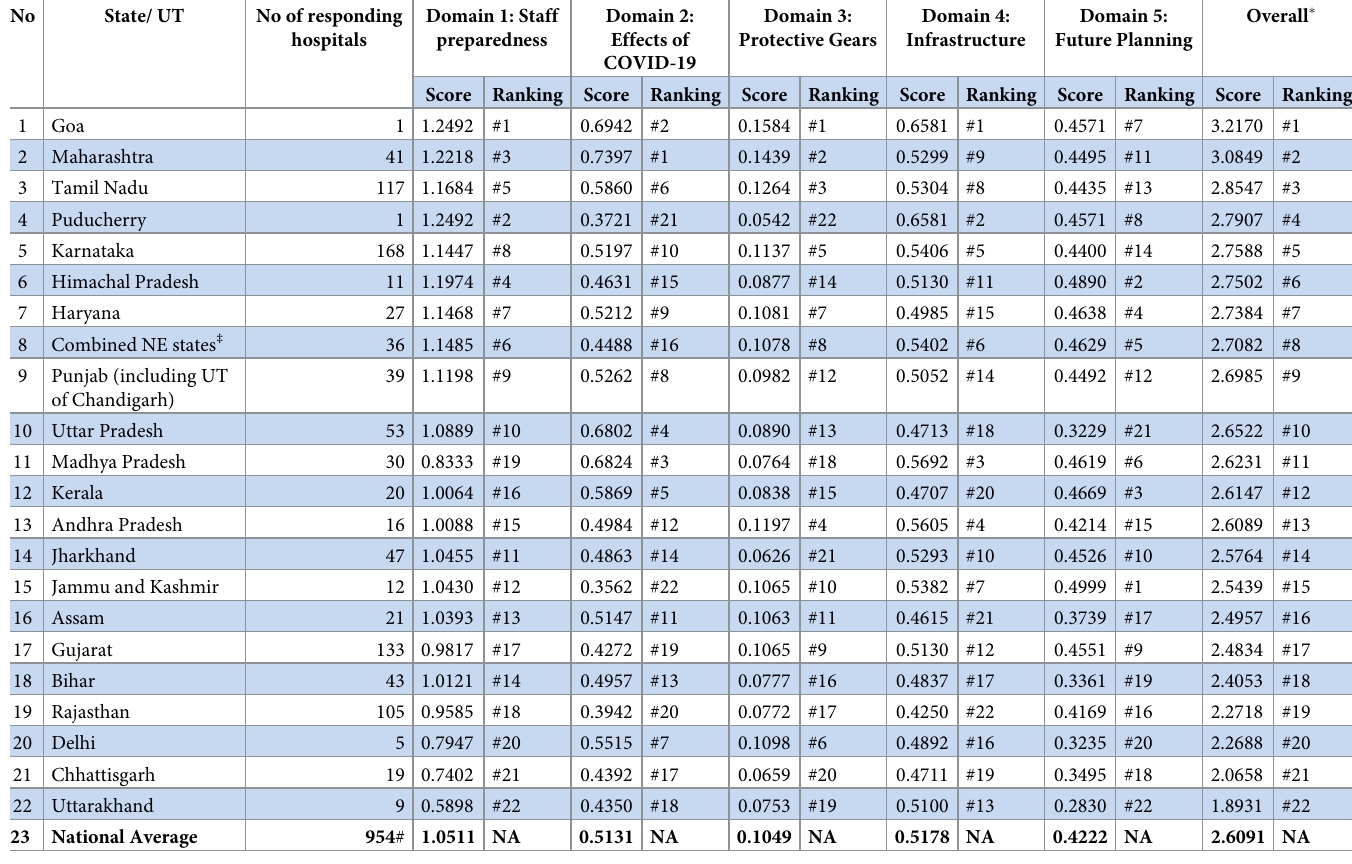
Table 3. Domain-wise and overall weighted negative log likelihood scores and ranking of preparedness index by States/ UTs in India.